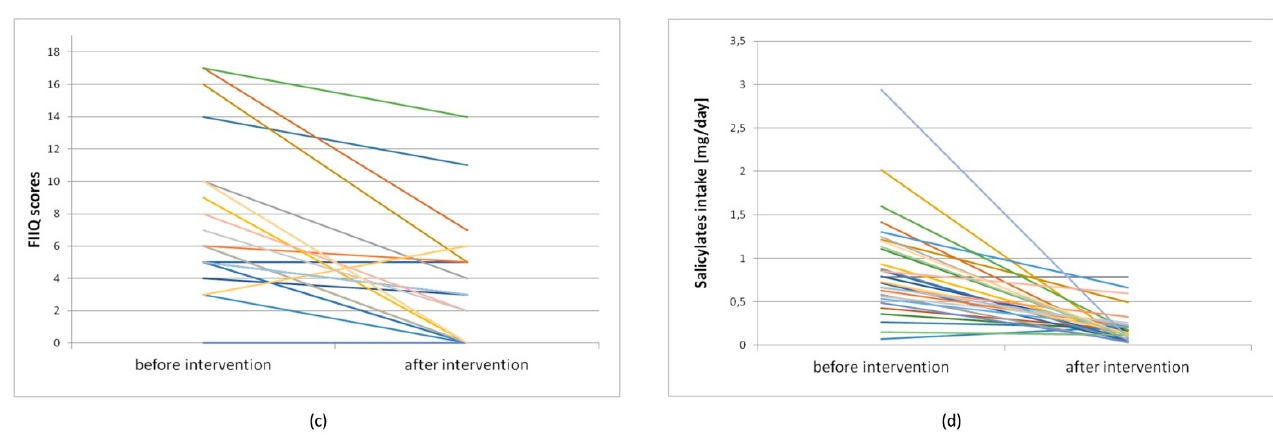
Figure 2. Individual results of the study participants: ( a ) individual results of “asthma control test” (ACT) scores before and after dietary intervention, n = 20; ( b ) individual results of “sino-nasal outcome test” (SNOT-22) scores before and after dietary intervention, n = 27; ( c ) individual results of “four-item itch questionnaire” (FIIQ) scores before and after dietary intervention, n = 23; ( d ) individual salicylates intake before and after dietary intervention, n = 30.